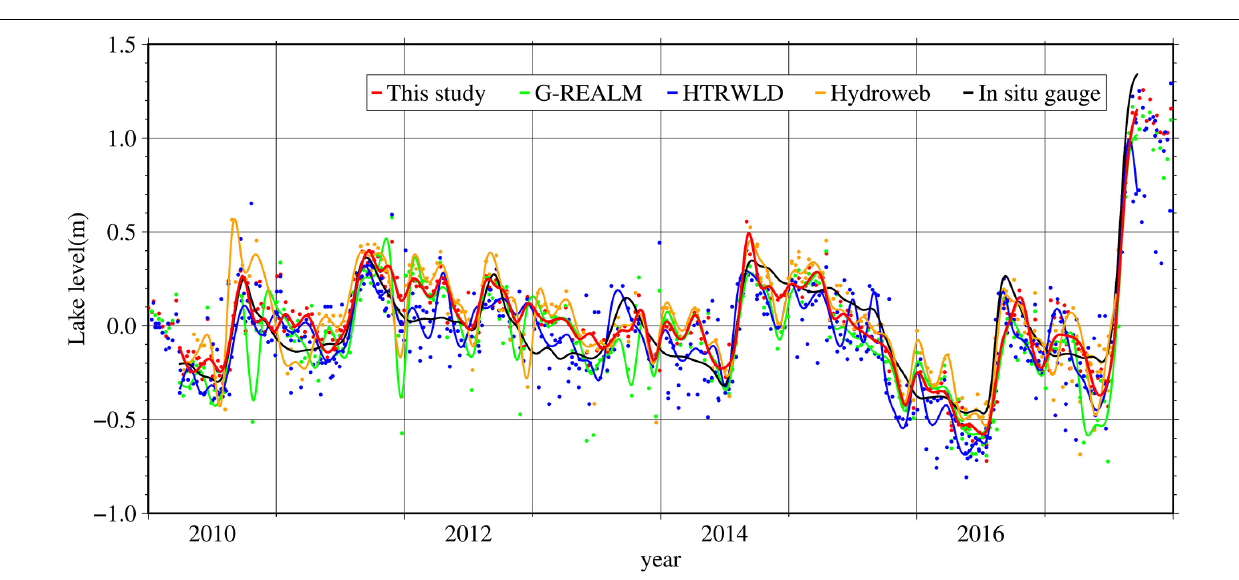
Frontiers in Earth Science |